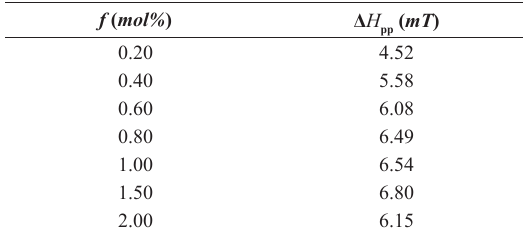
Table 2. Experimental results for the Gd 3+ -BaTiO ( T = 300 K, ν = 9.50 GHz).